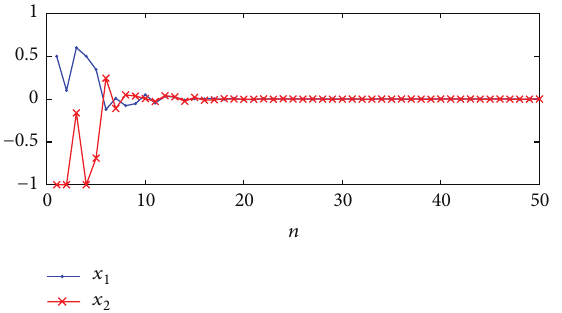
Figure 2: The response curves of system (36) with impulsive effects ( 𝛾 = 0.4761 ).